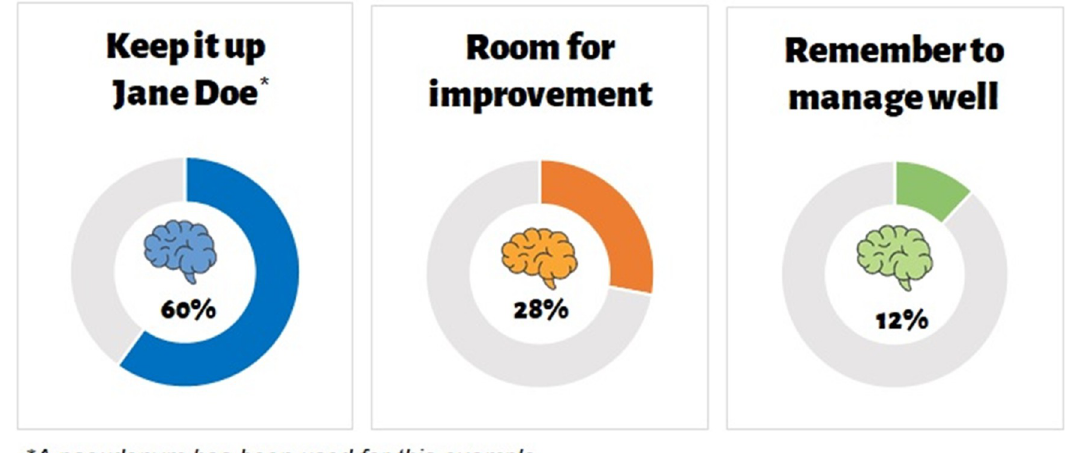
Fig 3. Example of a personalised brain health risk